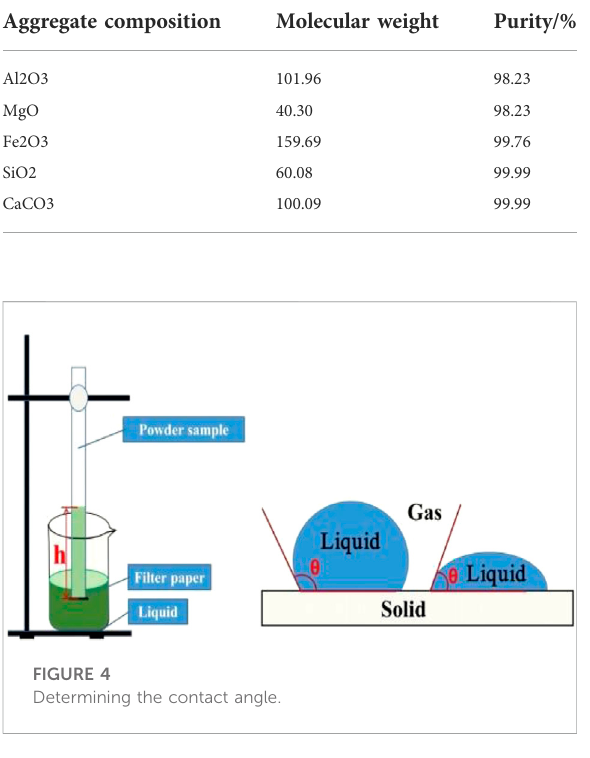
TABLE 2 Calculated aggregate powder contact angles ( θ / ° )